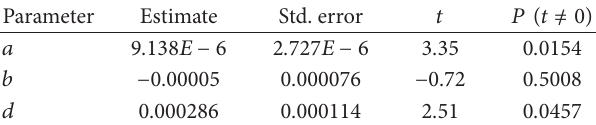
Table 1: Results of the regression analysis on the daily return observed: parameter estimates, standard error of the estimates, Student’s 𝑡 and probability of rejection.